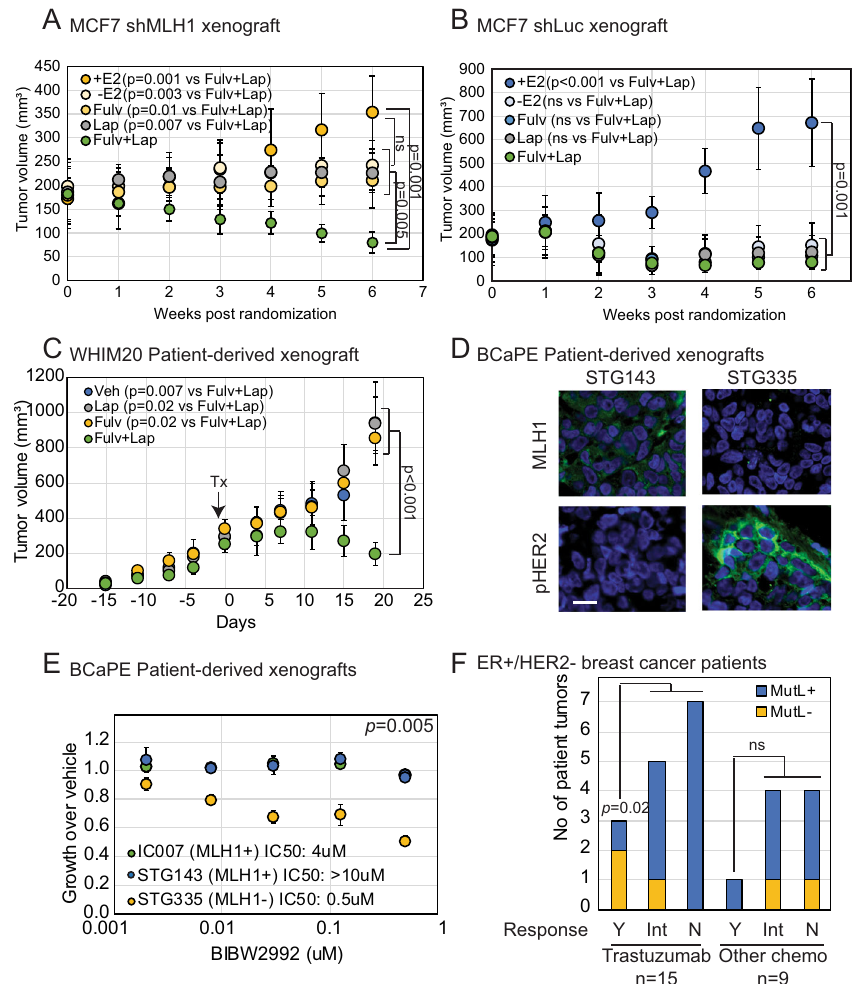
Fig. 5 MLH1 loss predicts sensitivity to HER inhibitors in endocrine-therapy-resistant ER + , HER2 − breast cancer cells in vivo and in patient tumors. In vivo xenograft experiments of MCF7 sh MLH1 ( A ), sh Luc ( B ) cells, and WHIM20 PDX line ( C ) demonstrating response in tumor growth to speci fi ed treatments. Control group: n = 5 mice; estrogen-deprived group: n = 4 ( A ), n = 5 ( B ), and n = 7 ( C ); lapatinib group: n = 6 ( A ), n = 5 ( B ), n = 4 ( C ); fulvestrant group: n = 5 ( A ), n = 6 ( B ), n = 3 ( C ); fulvestrant + lapatinib group: n = 8 ( A ), n = 6 ( B ), n = 5 ( C ). Circles represent the mean and error bars the standard deviation. Student ’ s t test determined p values by comparing slopes. For ( B ), + E 2 vs. fulvestrant + lapatinib-treated tumors, p = 0.0005 and for ( C ), fulvestrant + lapatinib-treated tumors vs. rest, p = 4.7e − 05. D Immuno fl uorescence depicting protein levels of MLH1 in two ER + /HER2 − PDX lines associating with HER2 activation after estrogen deprivation. Scale bar = 50 µ . E Growth curves demonstrating sensitivity of these PDX lines to HER inhibition ex vivo. IC50 calculated using regression analysis over three independent experiments and compared using two-sided Student ’ s t test. Circles represent the mean and error bars the standard deviation. Supporting data in Fig. S7A, B. F Categorical analysis supporting increased sensitivity of ER + /MutL − patient tumors to trastuzumab in combination with other chemotherapy. Supporting data in Fig. S7E, F. Y yes, Int intermediate, N no. Two- sided Fisher ’ s Exact test determined p values. For all regression analyses, individual p values and multiple adjusted R 2 values were derived using a linear model in R. Source data available with